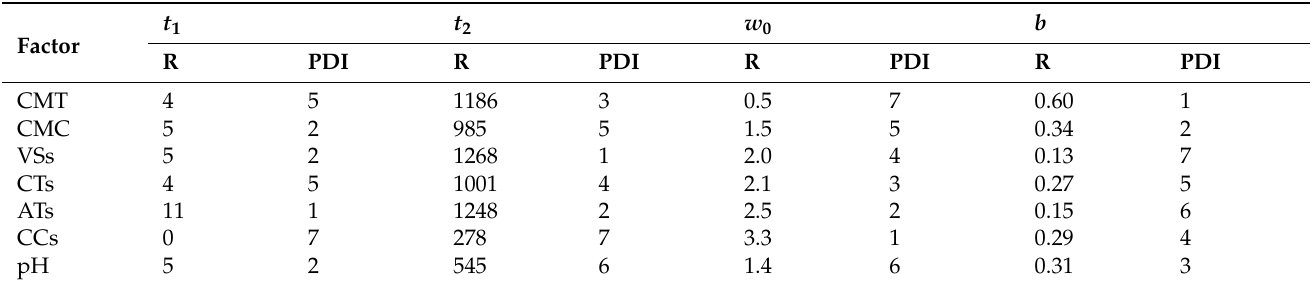
Table 3. Range value of the seven factors and degree of influence on the water absorption process of rocks. The larger the range value of the factor, the higher the priority of a factor’s degree of influence. PDI refers to the priority of degree of